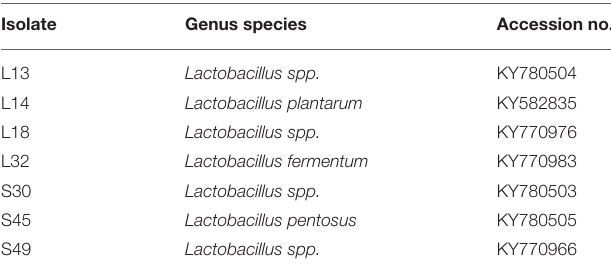
primers-27F Forward: 5 ′ -AGAGTTGATCCTGGCTCAG-3 ′ and 1492P Reverse: 5 ′ -TACGGCTACCTTGTTACGACTT-3 ′ .